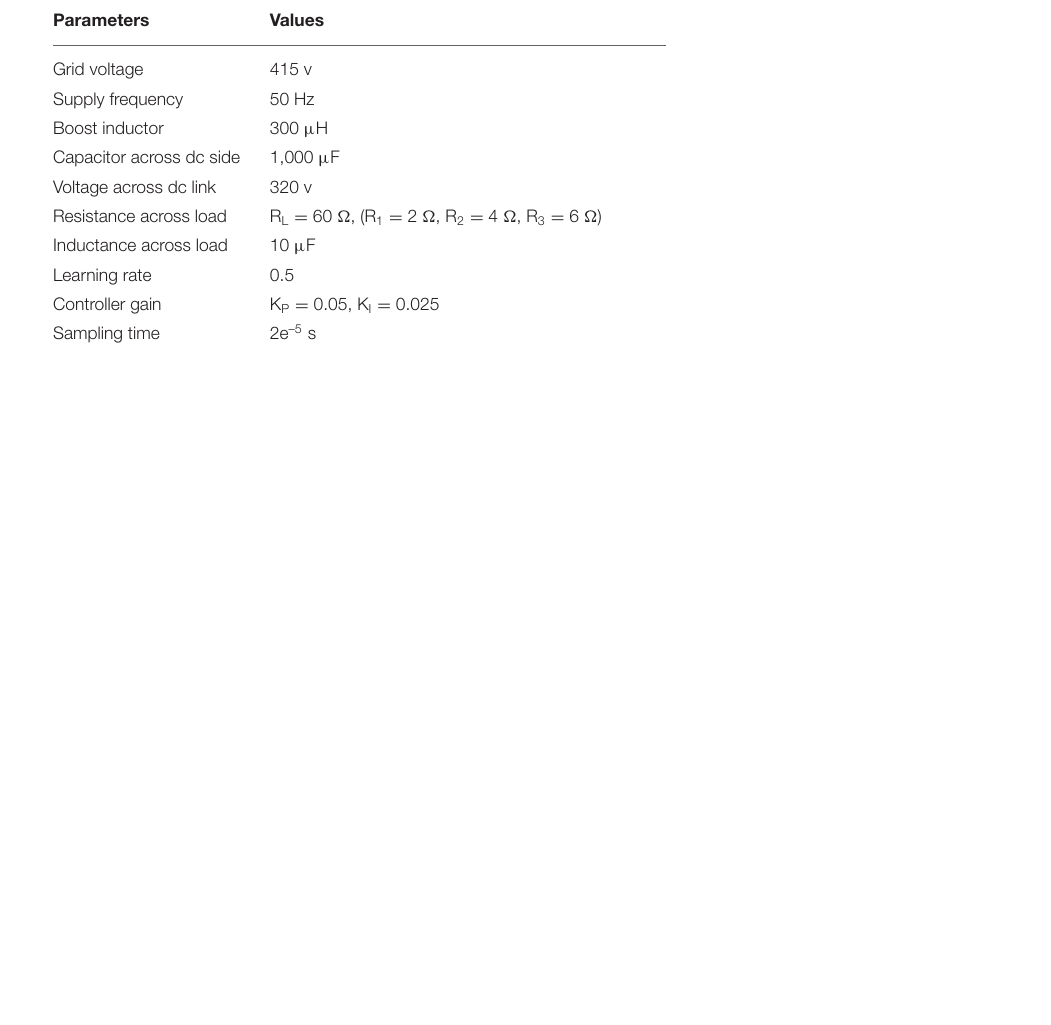
TABLE 1A | Parameters of the